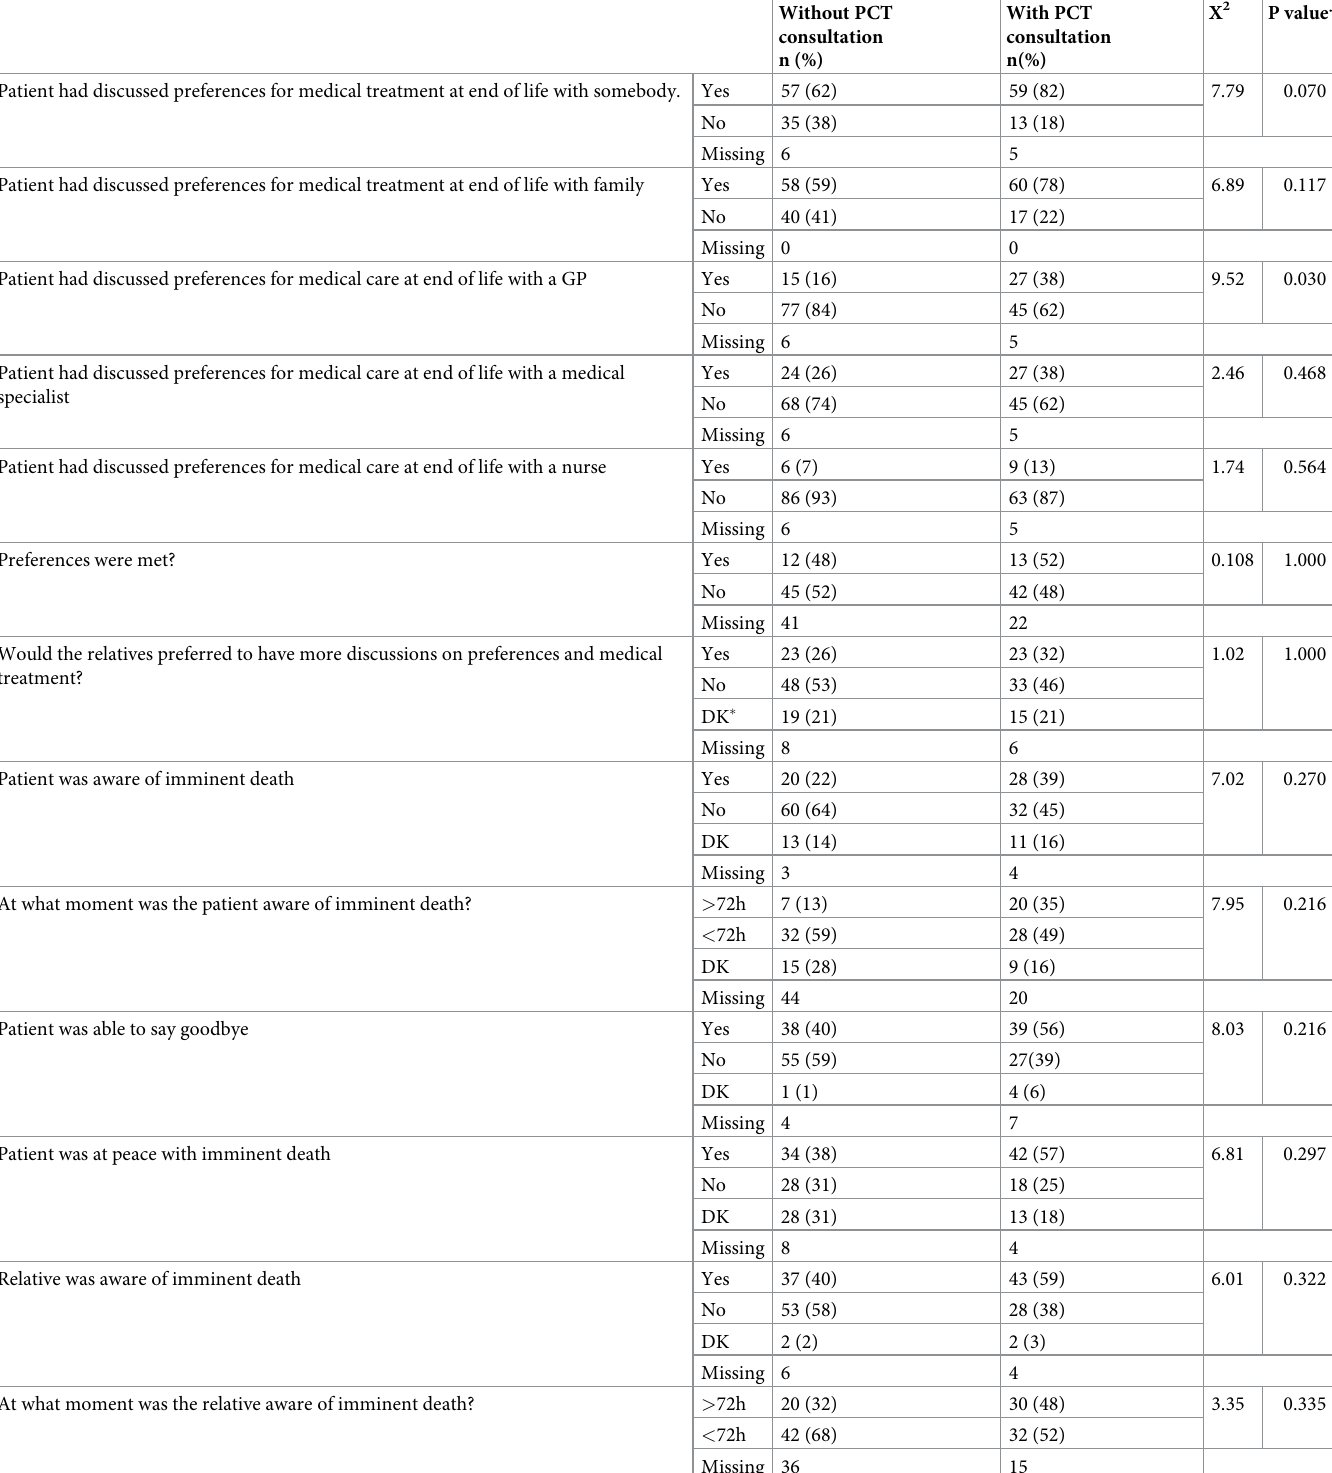
Without PCT With PCT X 2 P value† consultation consultation n (%) n(%)